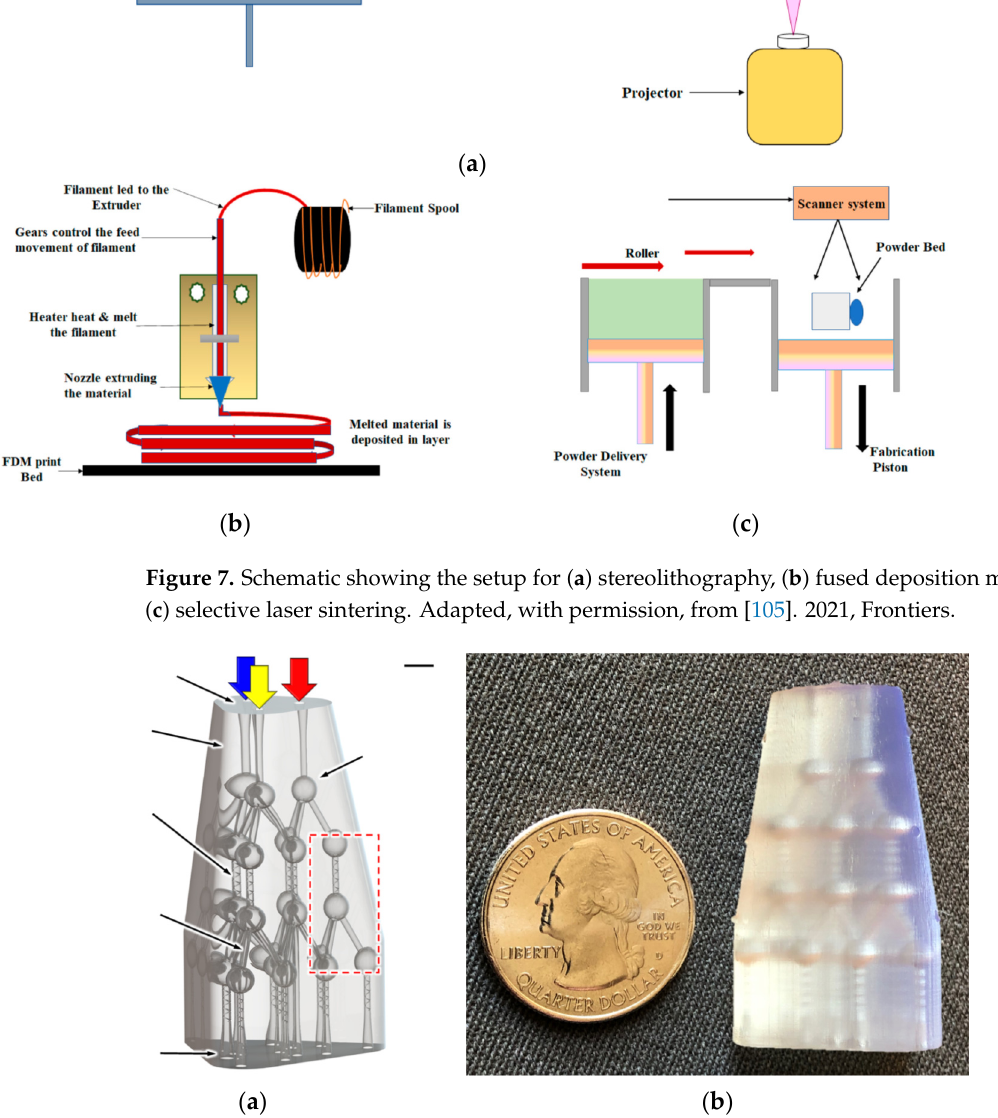
Figure 8. Developed 3D μ -CGG prototype and experimental setup. ( a ) Reverse solids model, repre- senting the manufacturable 3D microfluidic design comprising a single solid body with embedded hollow microchannel structures. ( b ) Fabrication results, actual 3D μ -CGG prototype after postpro- cessing; hollow interior structures are visible through the semitranslucent structural material, with US quarter for scale. Adapted, with permission, from [113]. 2020, Spring Nature.